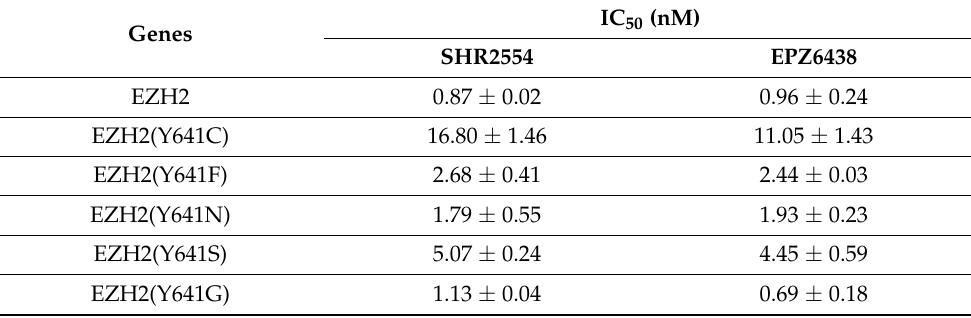
Table 1. Potency of SHR2554 against wild-type and mutant EZH2.